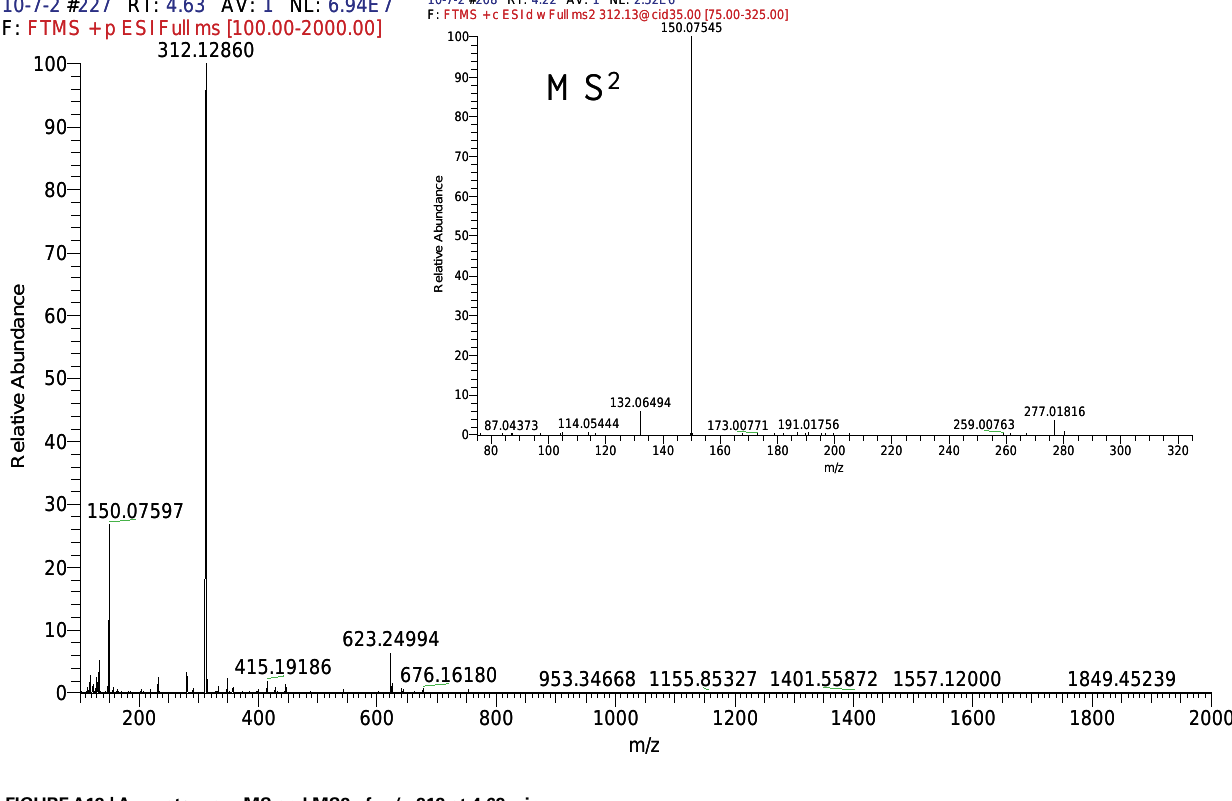
FIGUREA12 |Accurate mass MS and MS2 of m / z 312 at